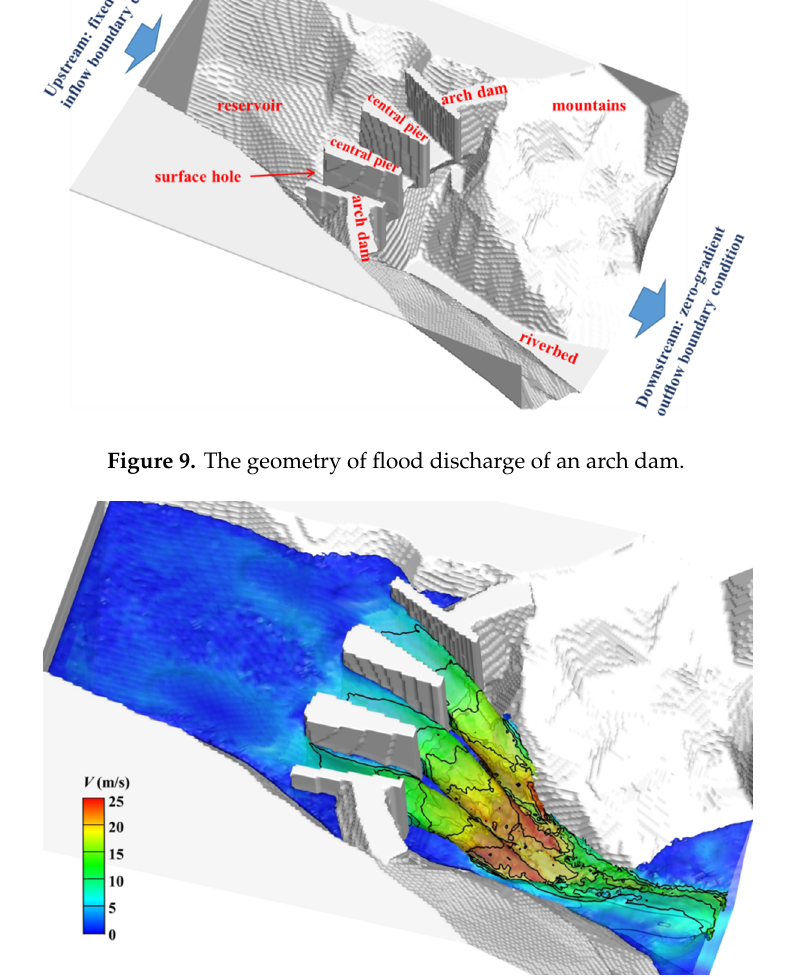
Figure 10. Water surface and velocity of flood discharge of an arch dam (reservoir water level: 450